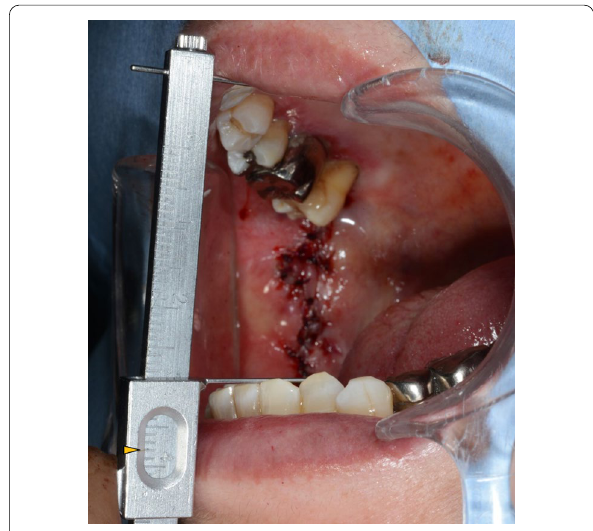
Fig. 8 Postoperative measurement photograph. Immediately after surgery, the patient’s mouth opening distance improved to 38 mm